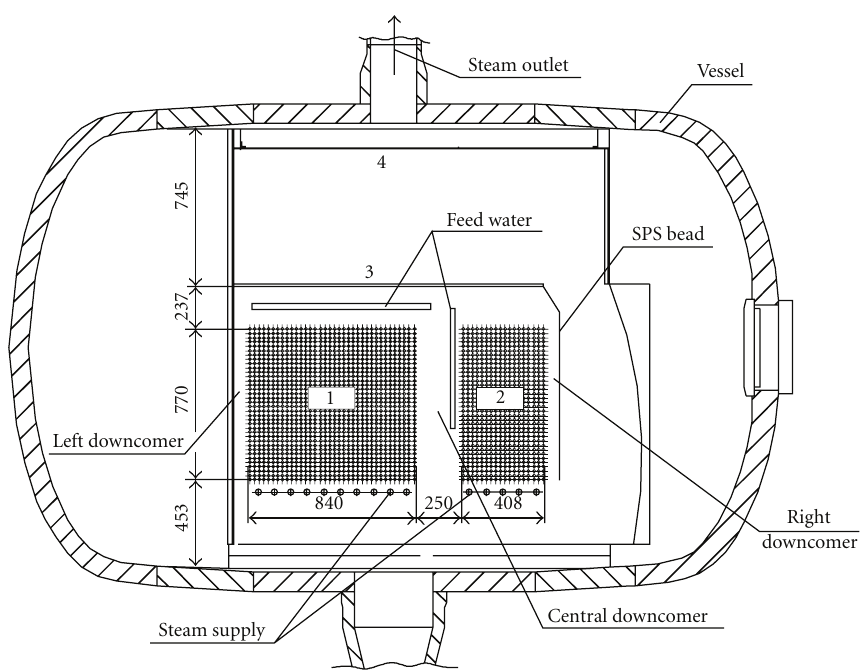
Figure 1: General view of experimental model. 1: heated tube bundle, 2: non-heated tube bundle, 3: SPS, and 4: SSPS.